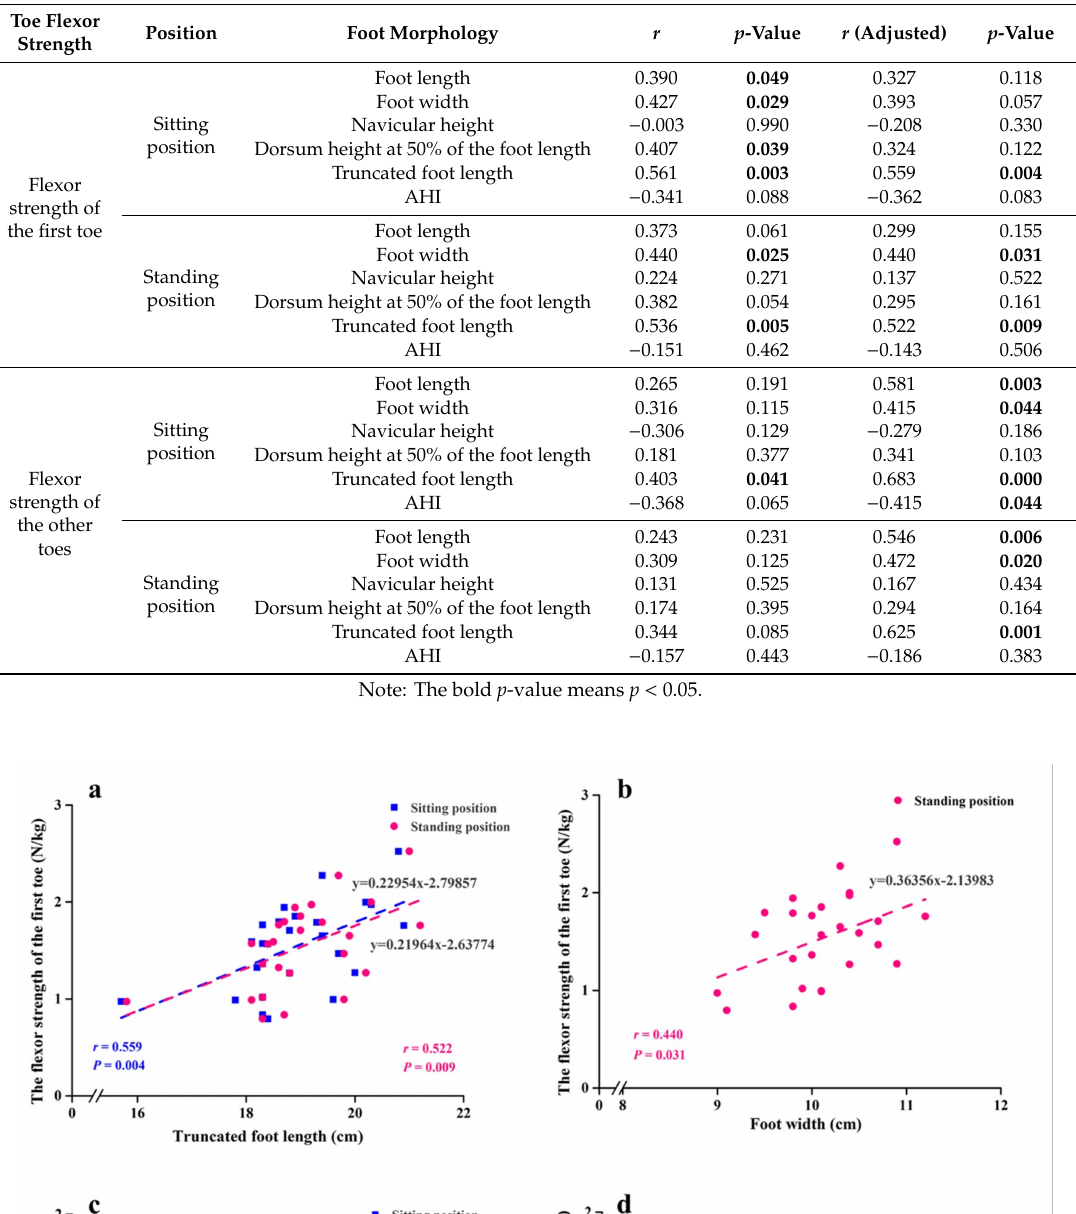
Table 3. Correlation coe ffi cient of foot morphology and toe flexor